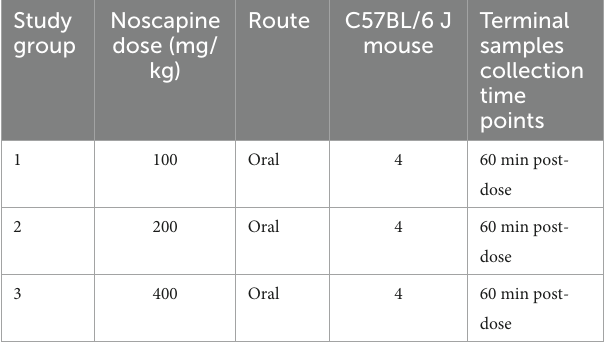
TABLE 2 Mouse noscapine treatment study plan. Study